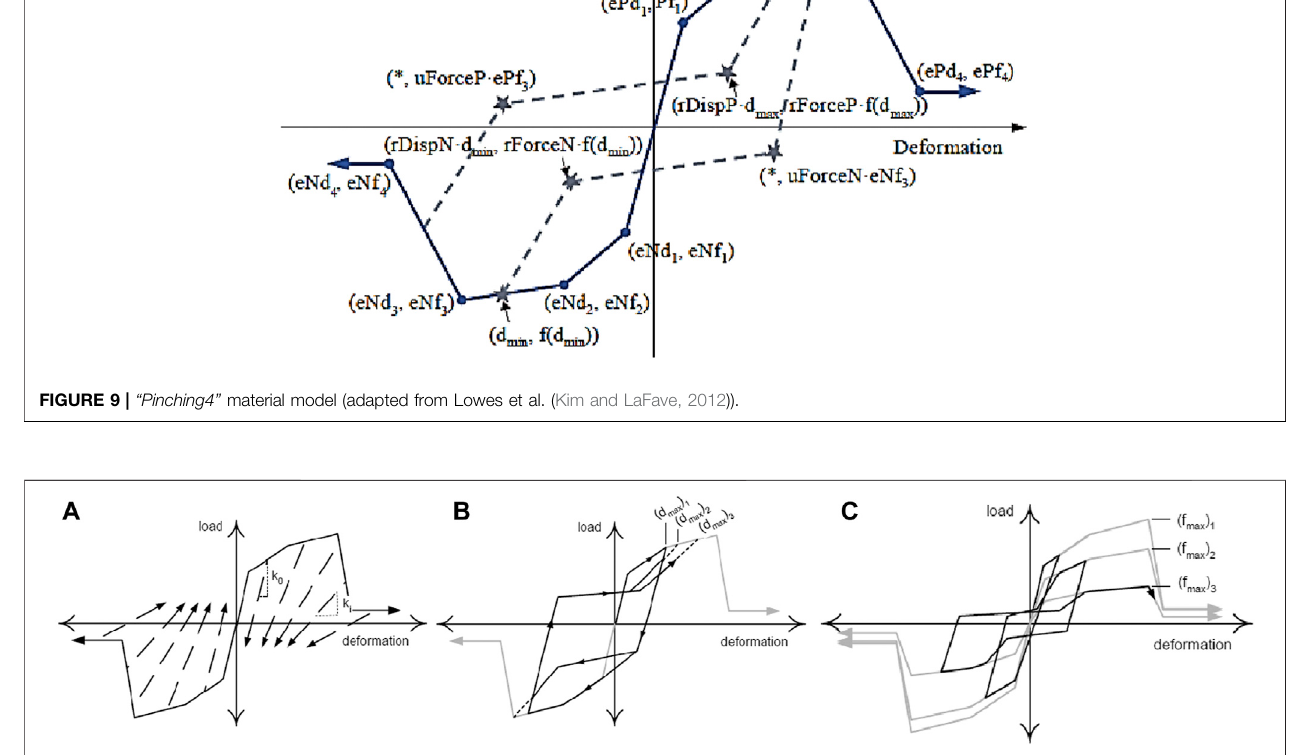
FIGURE10| Damagemodesofthe “ pinching4 ” material:unloadingstiffnessdegradation (A) ;reloadingstiffnessdegradation (B) ;strengthdegradation (C) (Genesio,2012).